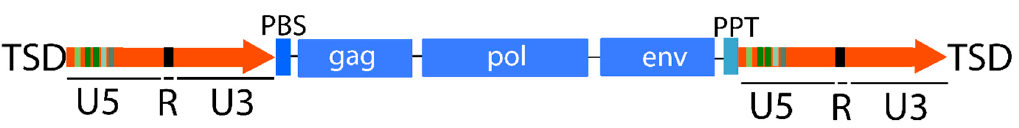
Figure 1. Structure of LTR retrotransposon. The env gene might not be present in some elements. Orange arrows correspond to LTRs.